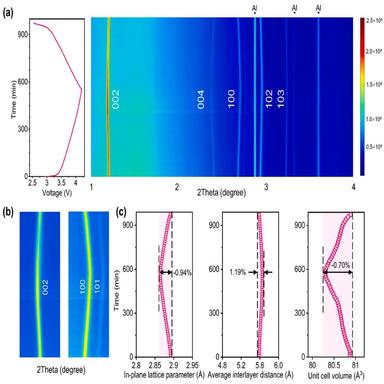
In-situ synchrotron HEXRD characterization on the structural evolution of NLCFM electrode. (a) The contour plot of in-situ XRD patterns collected under a current rate of 0.1C, with the corresponding first cycle electrochemical curves on the left. (b)Processed images of Bragg peaks (002), (100) and (101) for NLCFM. (c) The evolution of in-plane lattice parameter, average interlayer distance and unit cell volume for the NLCFM electrode fitted by in-situ synchrotron XRD patterns.